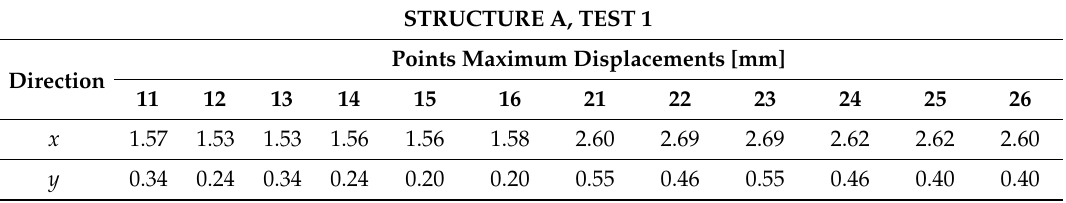
Table 8. Maximum displacements [mm] for each point, seismic action 1, combination (100% x , 30% y ).